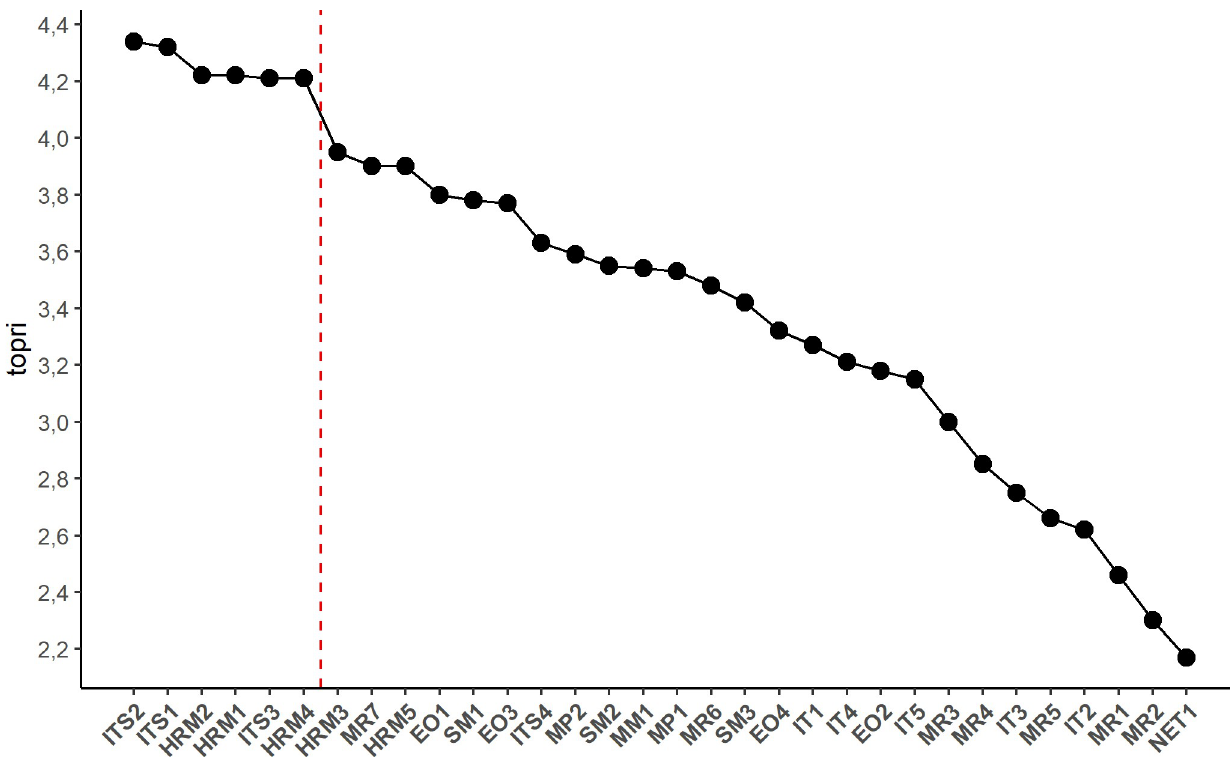
Fig 1. The graph of the topri index value for the each management